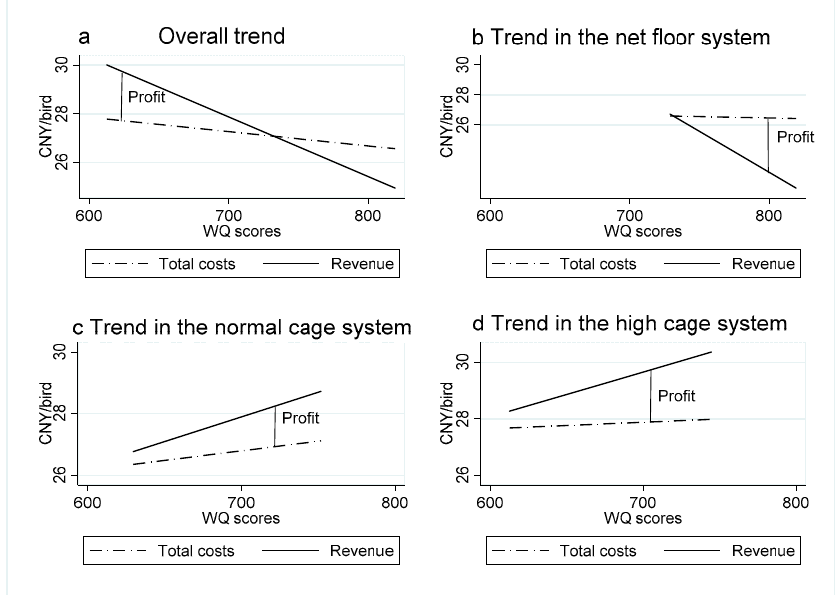
Figure 3. Correlation between the total cost, revenue profit and the WQ per system type. ( a ) Overall trend; ( b ) Trend in the net floor system; ( c ) Trend in the normal cage system; ( d ) Trend in the high cage system. Table 4. Chow test analysis of WQ index score, total cost, and profit. WQ Coef.